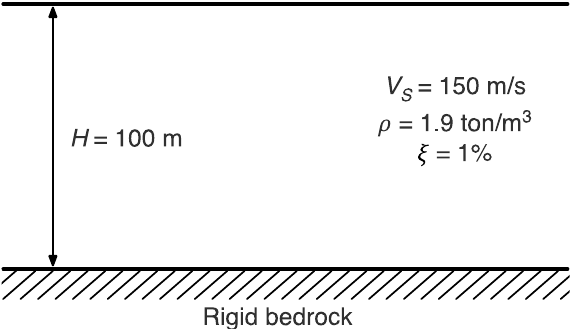
Figure 3. Scheme and basic properties of the academic soil profile.